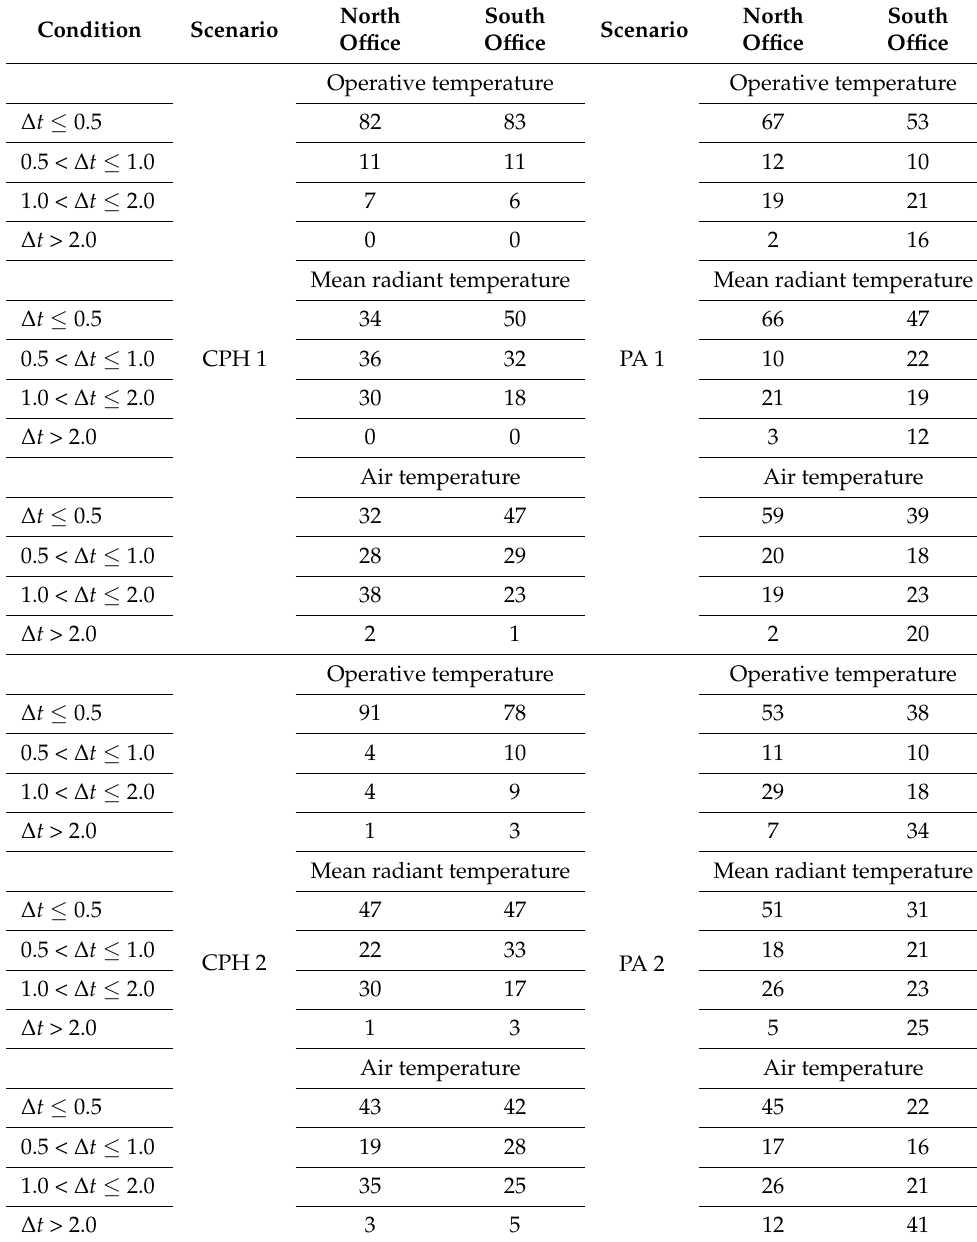
Table 6. Percentage of the time that the difference between the temperature values predicted by Design Builder and IDA ICE ∆ t (in ◦ C) falls into a specific condition. CPH 1: Copenhagen/scenario 1, CPH 2: Copenhagen/scenario 2, PA 1: Palermo/scenario 1, PA 2: Palermo/scenario 2.